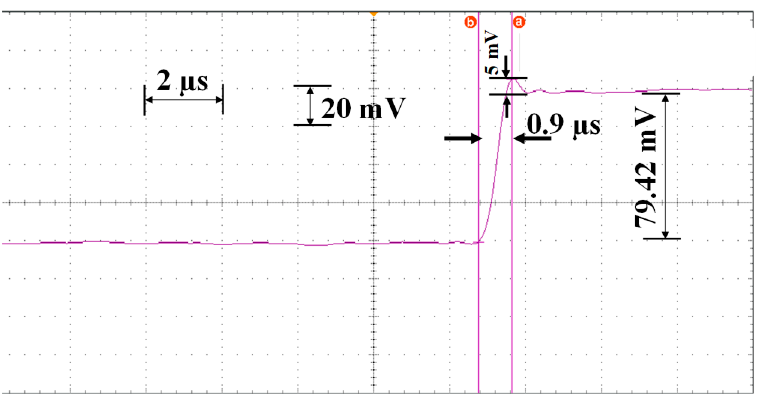
Figure 19. The measured results of settling time of the proposed SSC-DVS architecture.